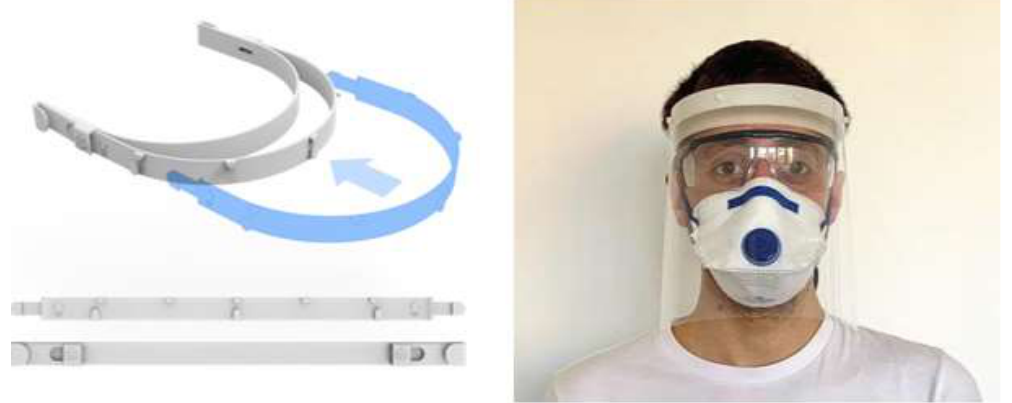
Figure 6. SLA-printed 3D Systems face shield by 3D Systems [56].